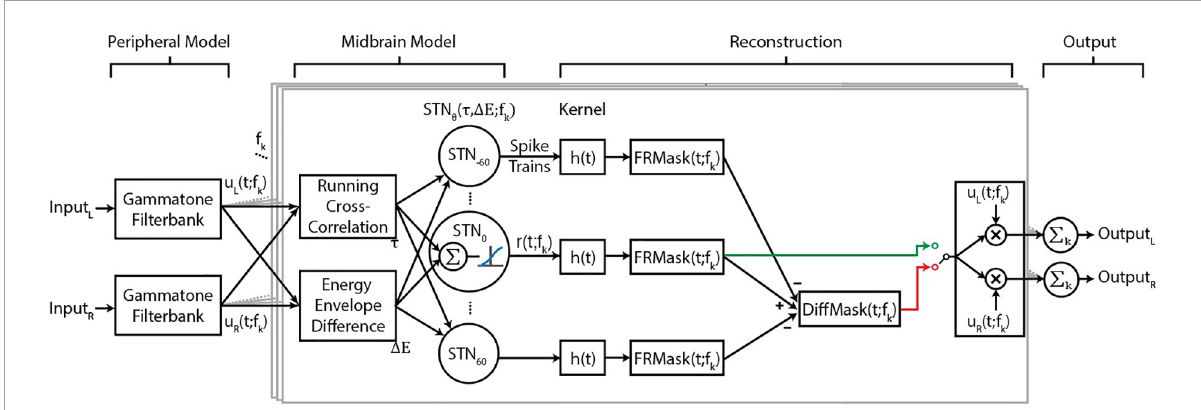
FIGURE1 Flow diagram of the proposed algorithm. Central boxes, outlined in gray, show processing for a single-frequency band. The functions u L (t; f k ) and u L (t; f k ) are the narrowband signals of the left and right input channels for each frequency channel, and f k denotes the k th frequency channel. The midbrain model is based on spatially tuned neurons (STNs), where each STN has a “best” ITD and ILD, denoted τ and (cid:49) E, respectively. The best ITD and ILD values of a neuron depend on the direction θ and frequency f k to which the STN is tuned. h ( t ) represents the reconstruction kernel that converts spike trains to waveforms. We implemented two masks, FRMask (green line) and DiffMask (red line), either of which could be used for reconstruction, as indicated by the switch, The implementation of DiffMask in our analysis involves five sets of STNs, where θ ∈ { 0 , ± 30 , ± 60 } ; however, other implementations of the model may involve different sets of θ .